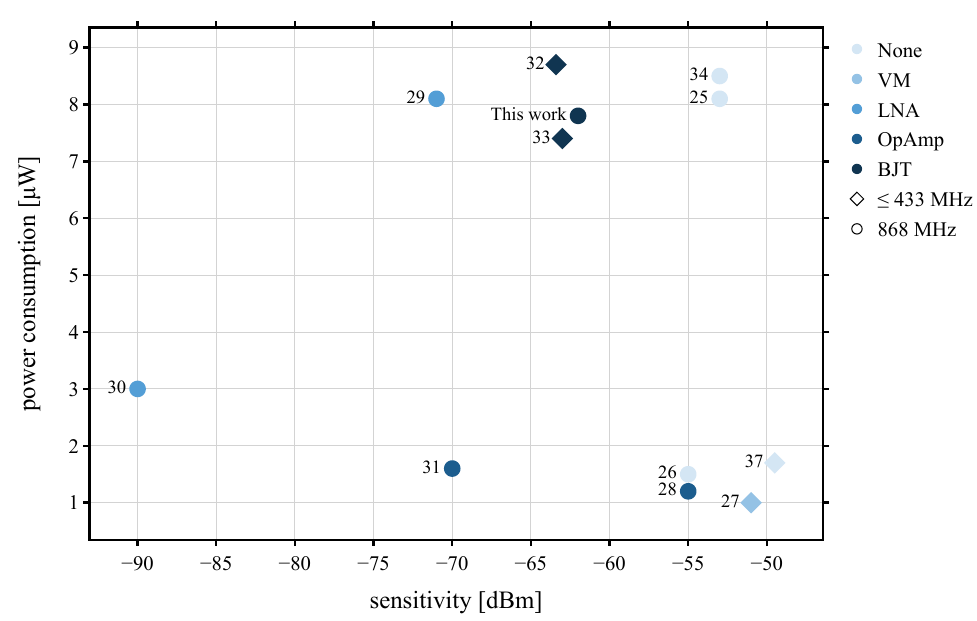
Figure 2. Comparison of SoA WuRx architectures.